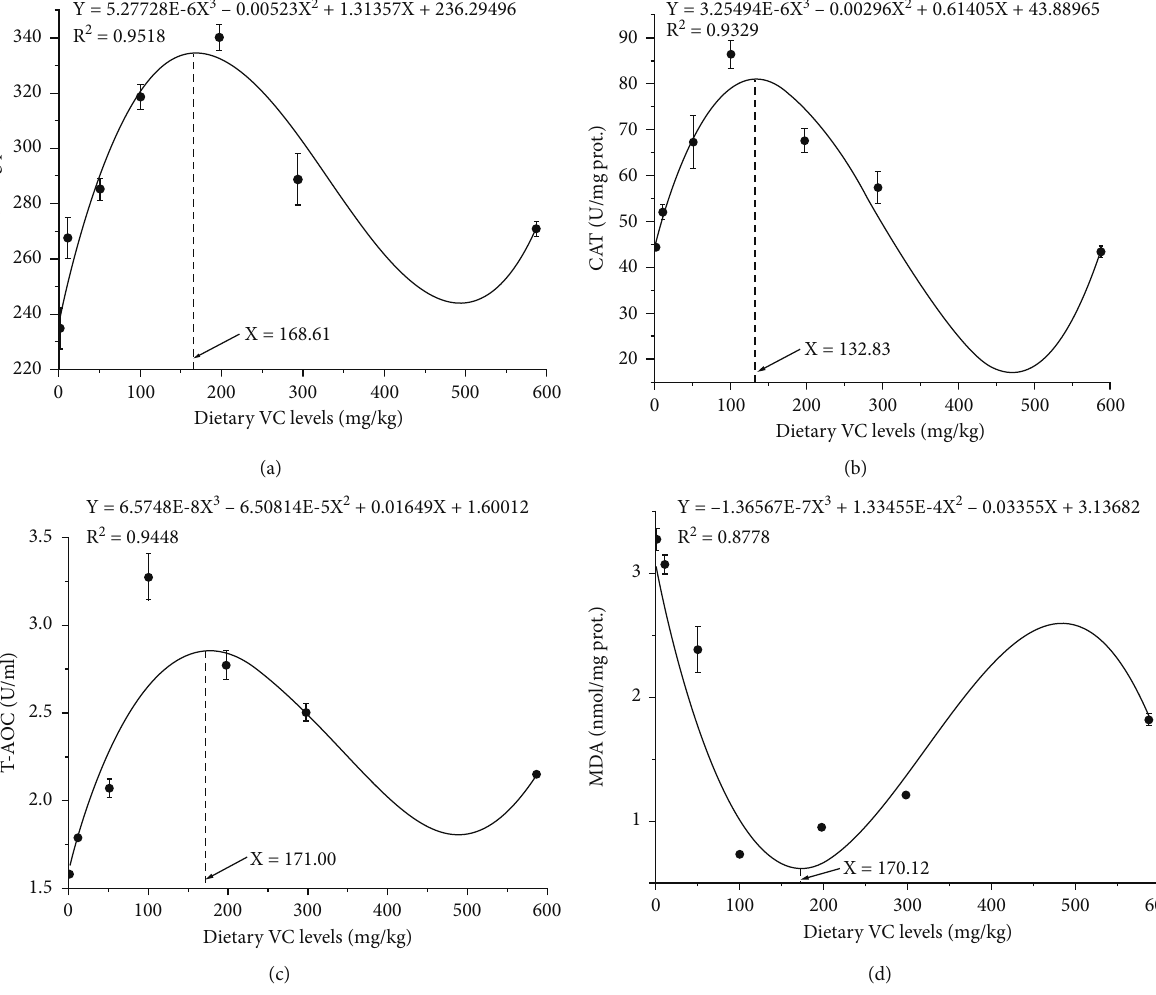
Figure 4: Cubic regression analyses of SOD, CAT activities, MDA concentration, and serum T-AOC activity with dietary vitamin C (VC) levels in coho salmon Oncorhynchus kisutch (Walbaum, 1792) postsmolts. The predicted dietary VC requirements of SOD, CAT, T-AOC, and MDA are 156.57, 132.83, 171.00, and 170.12 mg/kg, respectively. Abbreviation: SOD: superoxide dismutase; CAT: catalase; T-AOC: total antioxidative capacity; MDA: